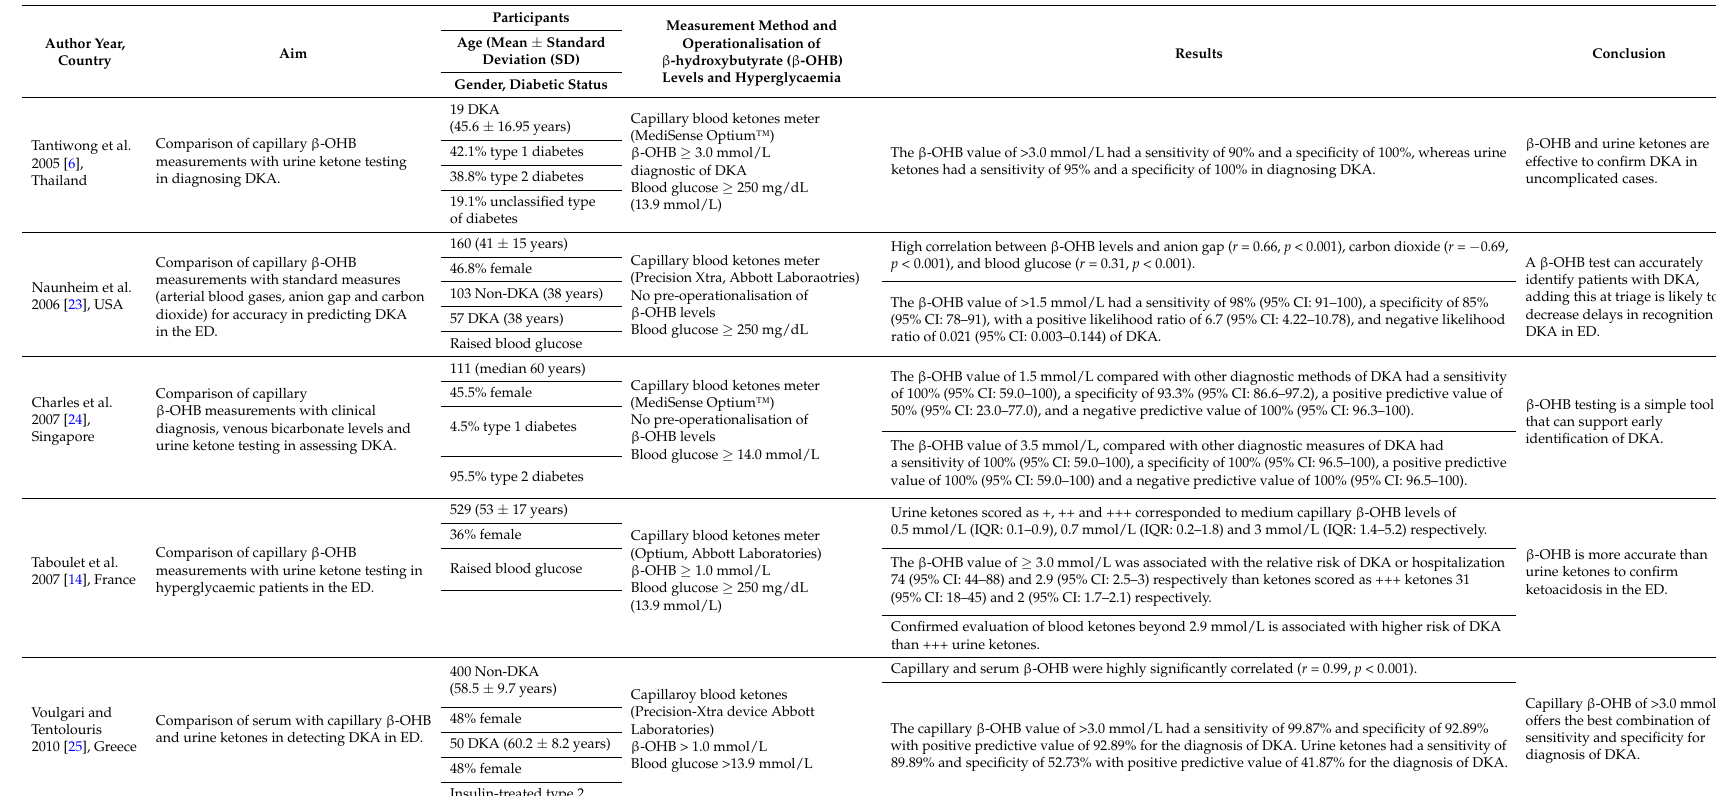
Table 2. Overview of included